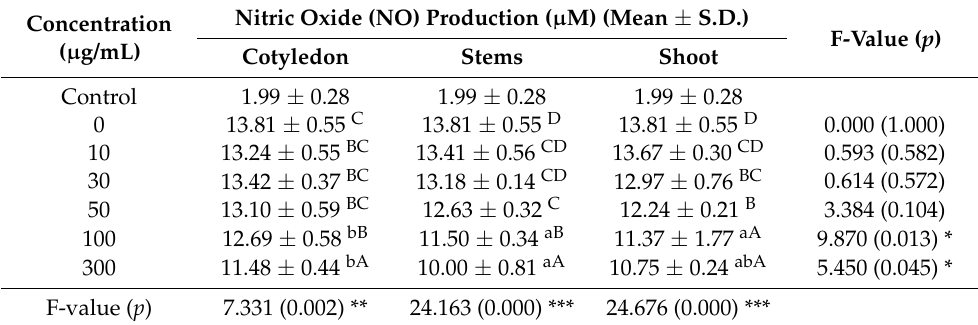
Means with different letters in each column (common letter (a–c): the level of significance for each organs) and row (capital letter (A–D: the level of significance for each treatment with µ g/mL) are significantly different by Duncan’s multiple range test ( p < 0.05). Values are mean ± SD (n = 3). ). * p < 0.5, ** p < 0.01, *** p < 0.001 compared to the control by